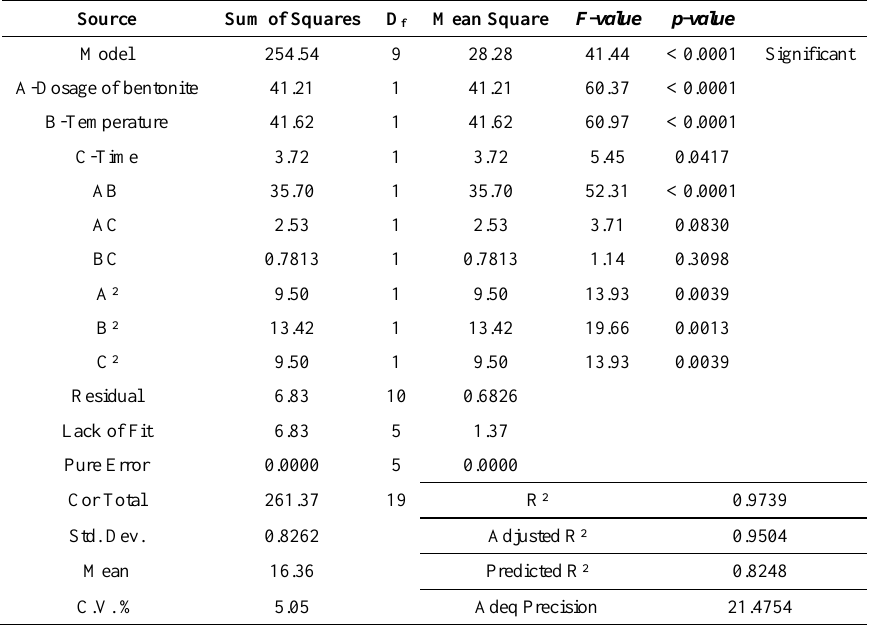
Table 6. ANOVA results of viscosity of OBMB